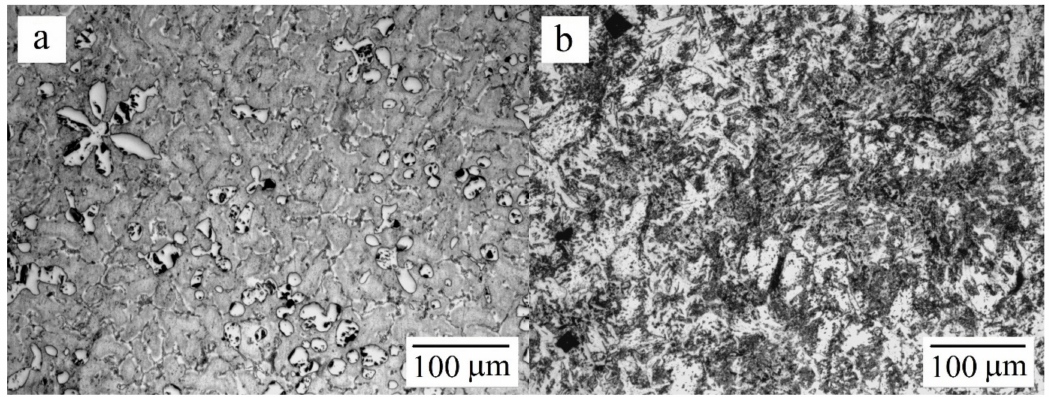
Figure 2. Optical microscopy microstructure of Al 0.25 CoCrFeNiV HEA; without EMP ( a ) and after EMP ( b